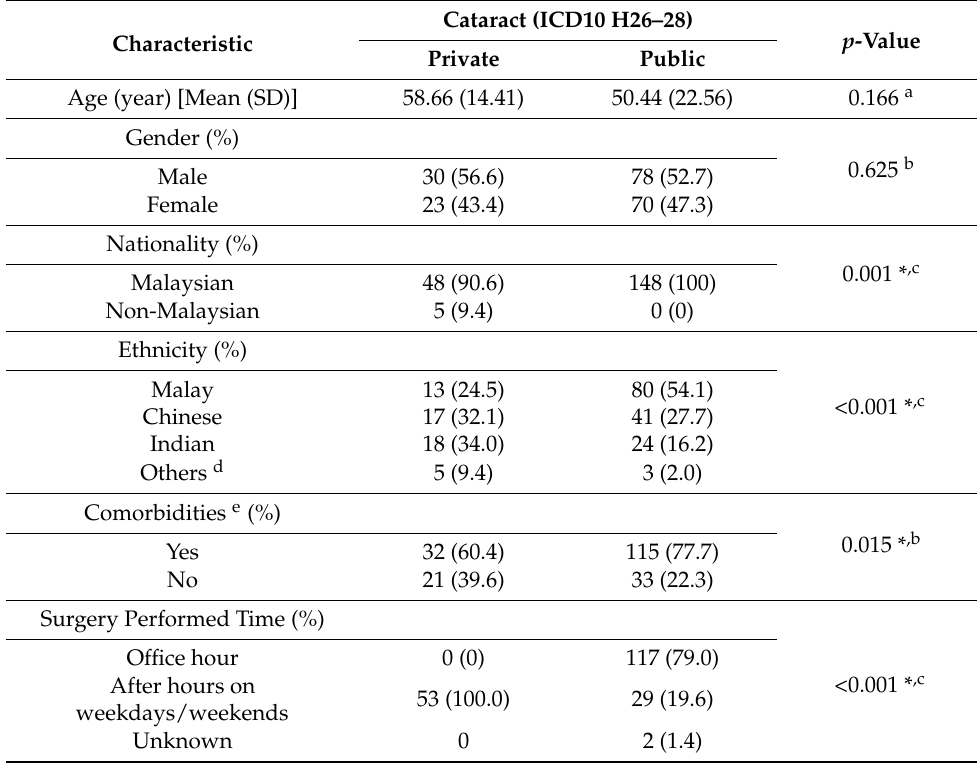
Figure 2. Flow chart of sampling method for cataract patients. Table 1. Socio-demographic characteristics of public and private